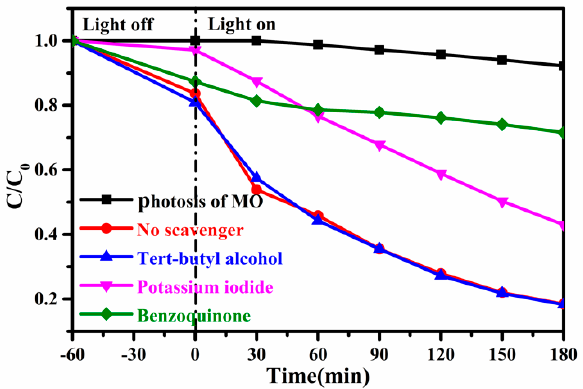
Figure 11. Photocatalytic degradation of MO by the Bi 3 O 5 I 2 under the presence of different scavenging species.